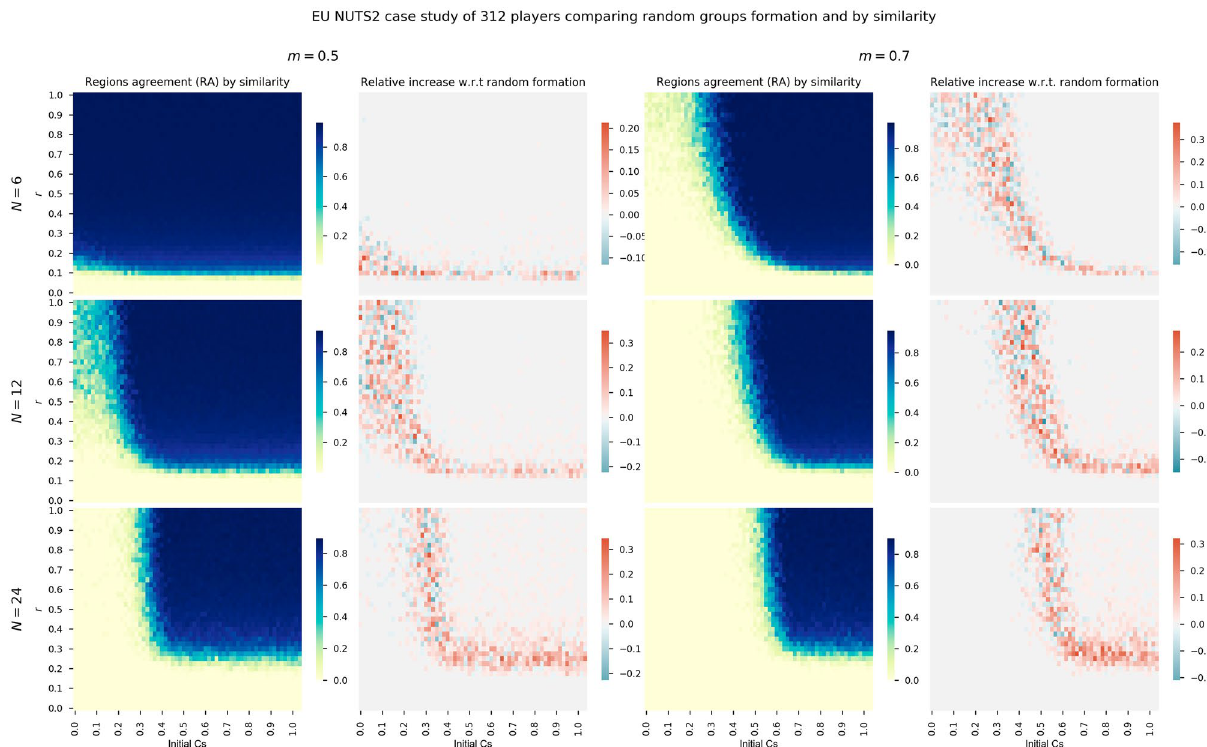
Figure 8. First and third columns show heatmaps of absolute RA when considering the real data from the 312 NUTS2 regions, grouped at random for thresholds m = 0.5 and m = 0.7 . The second and fourth columns show relative RA differences when grouping by similarity with respect to random